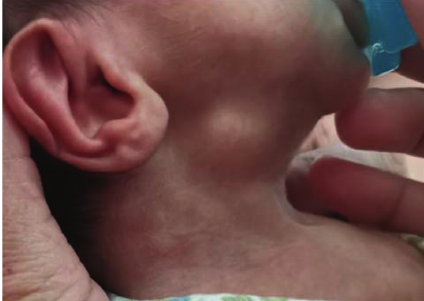
Figure 2: Submandibular gland